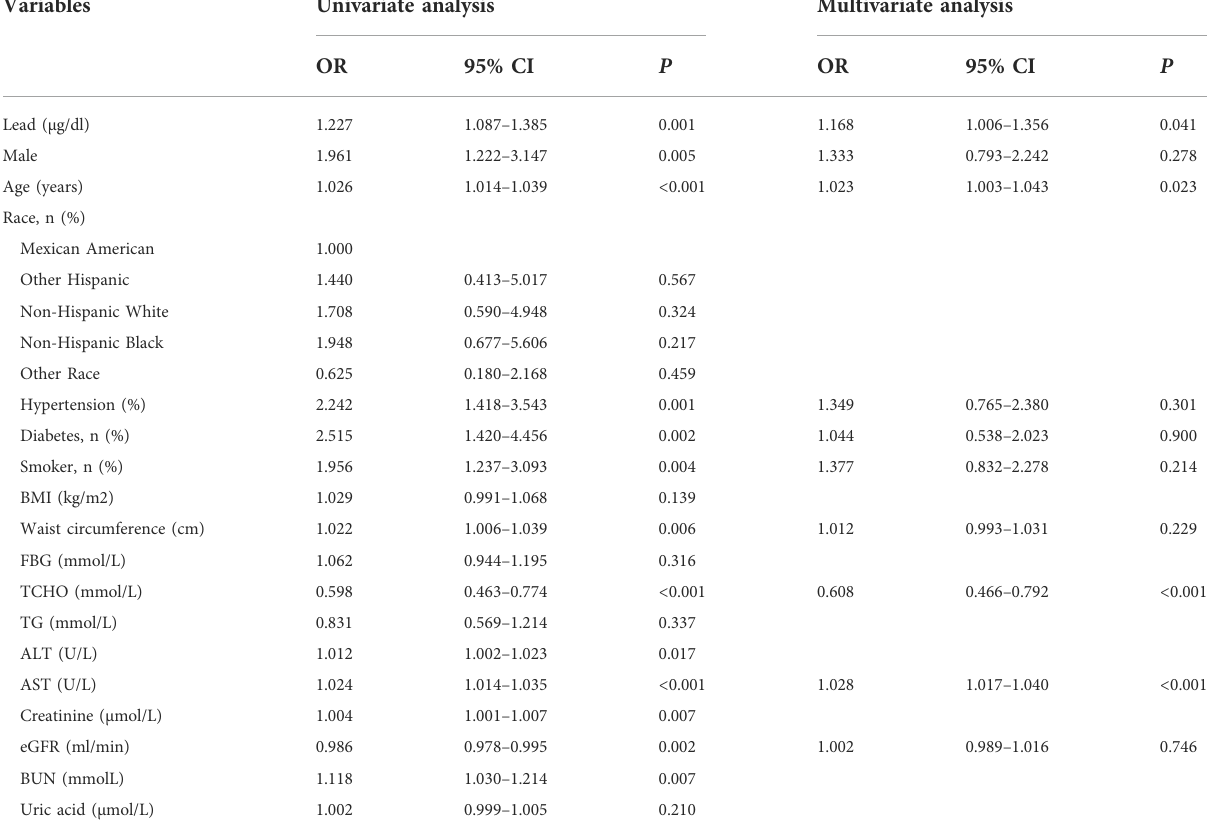
TABLE 4 Binary logistic regression analysis of blood lead and signi fi cant fi